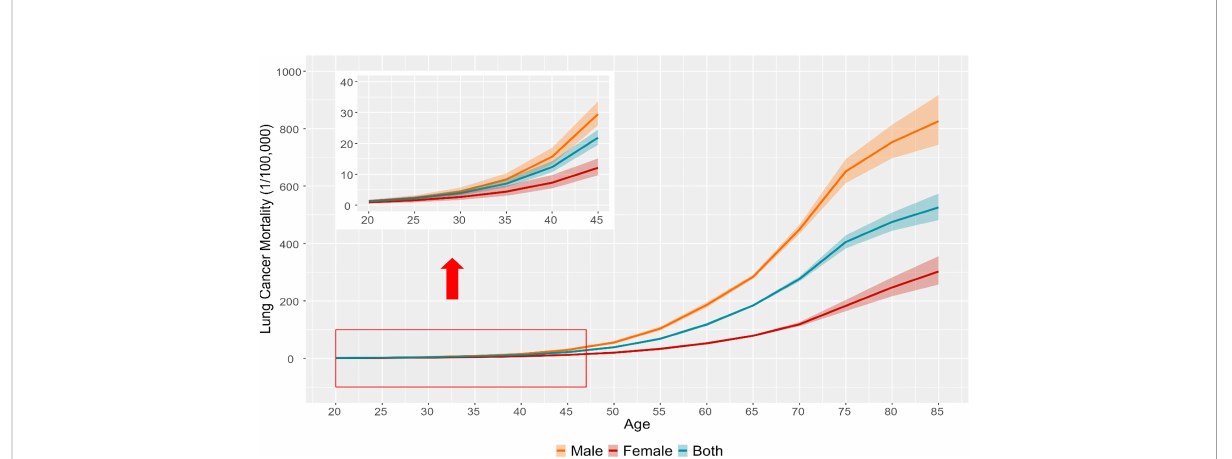
Figure 4 demonstrated changes in the ASMRs and ASYLLRs of lung cancer and the corresponding ranks of the ASRs in the population of 13 administrative regions in Wuhan. The ASMRs of lung cancer in the population of Xinzhou District were the highest among all administrative regions over the whole study period, followed by Jiangxia District. Residents in Wuchang District and Hannan District suffered severe death from lung cancer during 2011-2013 or 2016-2017, but the situations been